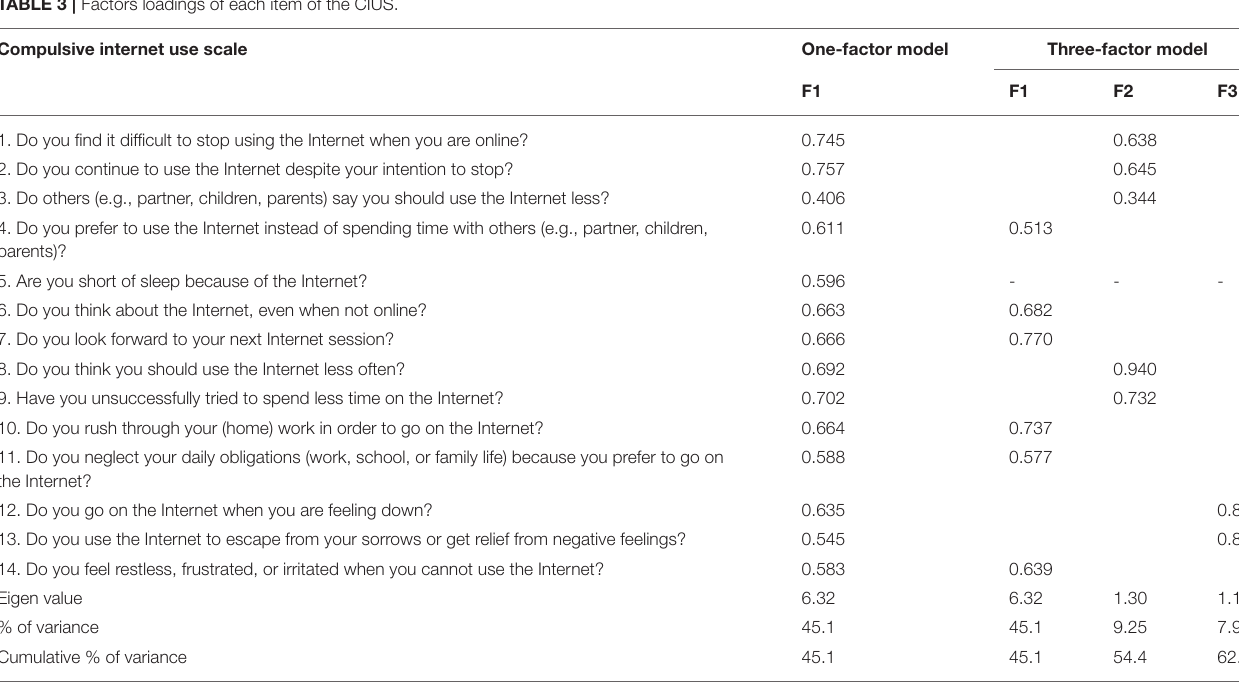
TABLE 3 | Factors loadings of each item of the